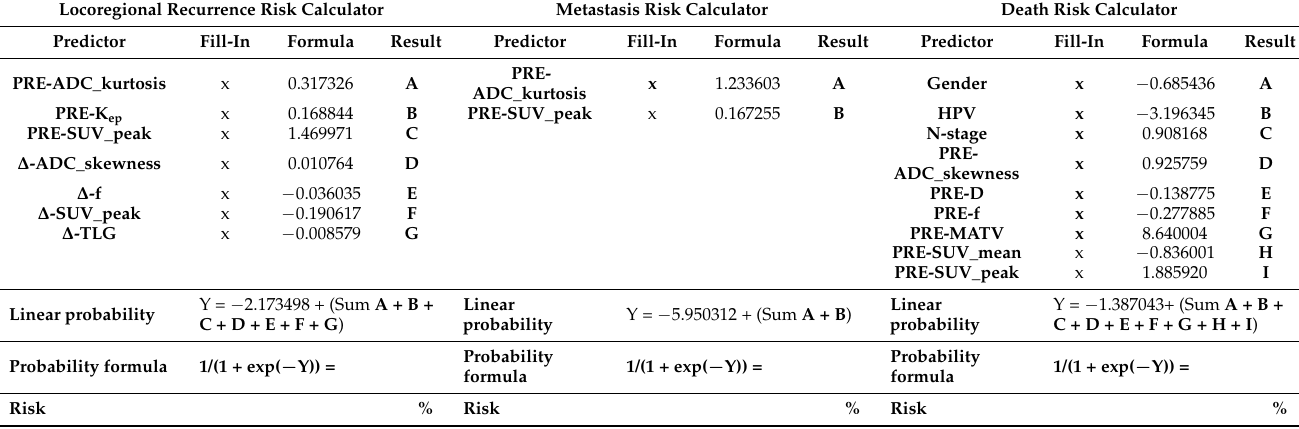
Table 4. The risk-of-locoregional-recurrence calculator, which can be used in clinical practice to calculate the risk per specific patient of locoregional recurrence during the follow-up time of 2 years. The yellow boxes can be filled in with the specific patient data in order to calculate the risk of locoregional recurrence, distant metastasis or death, in which gender is either 1 (male) or 0 (female). HPV status is either 1 (positive) or 0 (negative) and N-stage is either 0 (stage 0–1) or 1 (stage 2–3). The risk-of-metastasis calculator, which can be used in clinical practice to calculate the risk per specific patient of metastasis during the follow-up time of 2 years. The yellow boxes are filled in with the single patient data (with a large tumor) in order to calculate the risk of metastasis. The risk-of-death calculator, which can be used in clinical practice to calculate the risk per specific patient of death during the follow-up time of 2 years. The yellow boxes can be filled in with the single patient data in order to calculate the risk of